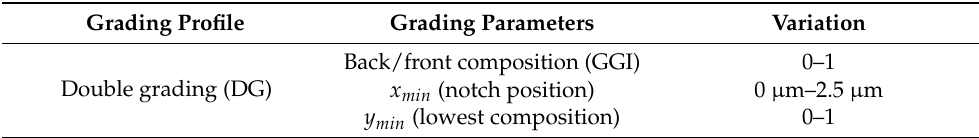
Table 2. The Variation in Grading Parameters